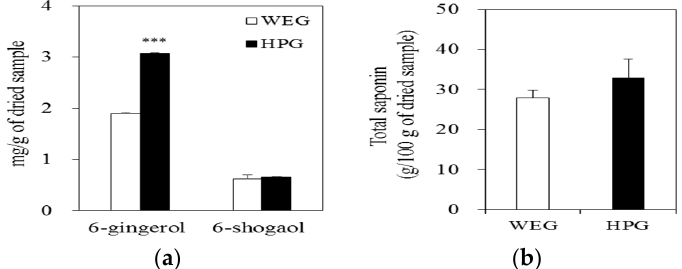
Figure 2. Bioactive compositions of WEG and HPG. ( a ) 6-gingerol and 6-shogaol of WEG and HPG and ( b ) total saponin of WEG and HPG. Values are expressed as mean ± SEM ( n = 3) of three independent experiments. *** p < 0.001 compared to the WEG. WEG: hot water extract of ginger; HPG: high-hydrostatic pressure extract of ginger.